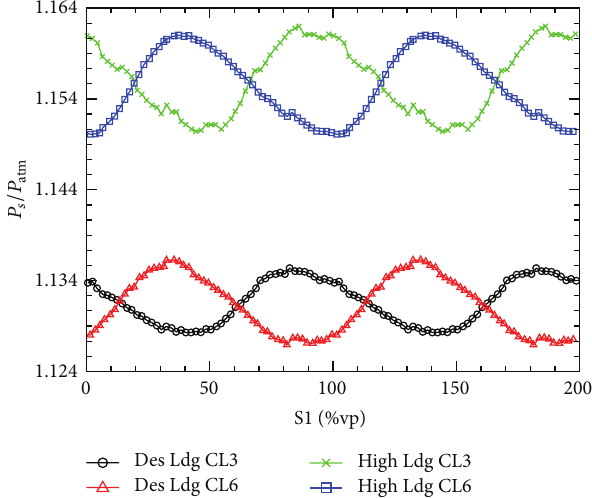
Figure 2: Casing static pressure at Rotor 2 exit for both clocking configurations at design and high